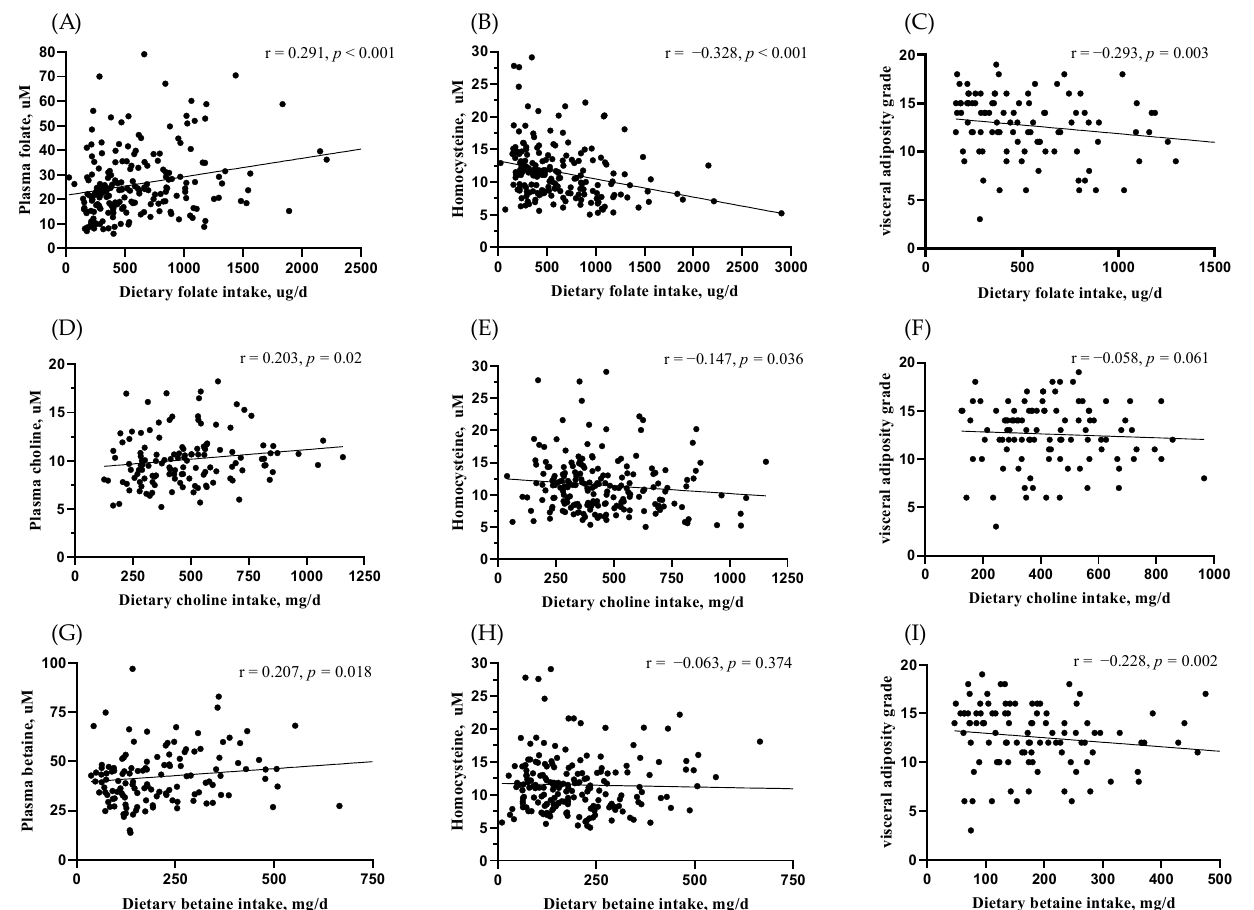
Figure 2. Association of MDNs intake with their blood markers and visceral adiposity. Association of MDN intake with their blood biochemical markers and Hcy levels for folate ( A , B ), choline ( D , E ) and betaine ( G , H ) in the total study subjects was analyzed by spearmen coefficient. Spearmen correlation of MDNs intake with visceral adiposity for folate ( C ), choline ( F ) and betaine ( I ) was analyzed in the HS group. Differences were considered to be statistically significant at p < 0.05.